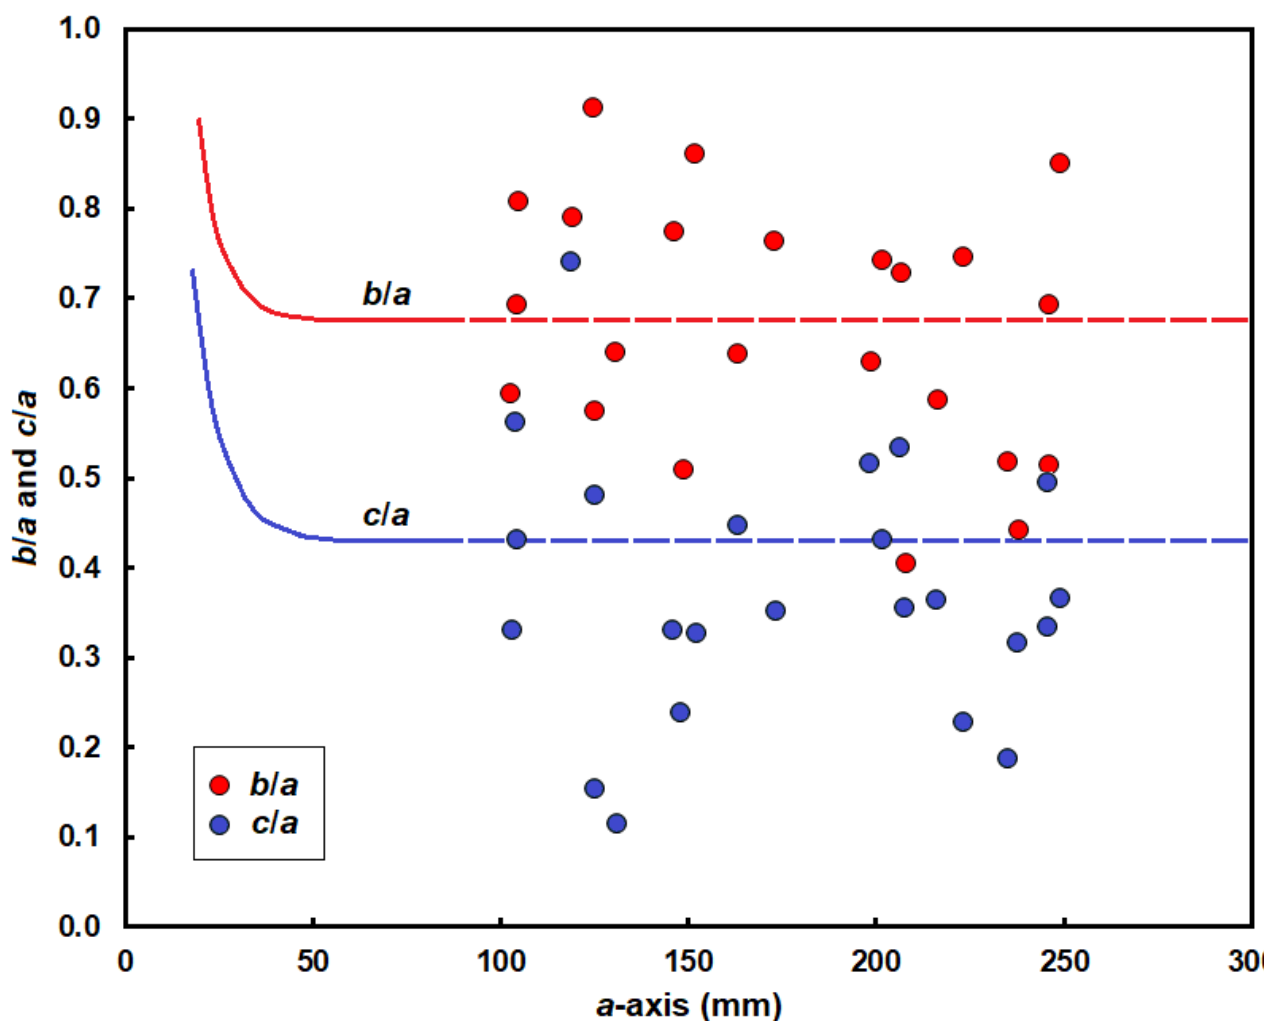
Figure 5. The b / a and c / a axis ratios of freshly weathered gravels of Navilawa Monzonite from the Sabeto River valley of western Viti Levu, Fiji as a function of particle a -axis length. The two sub-parallel lines represent the best-fit models of Domokos et al. [47], corresponding to the claimed shapes of particles generated by weathering, impact and explosion.